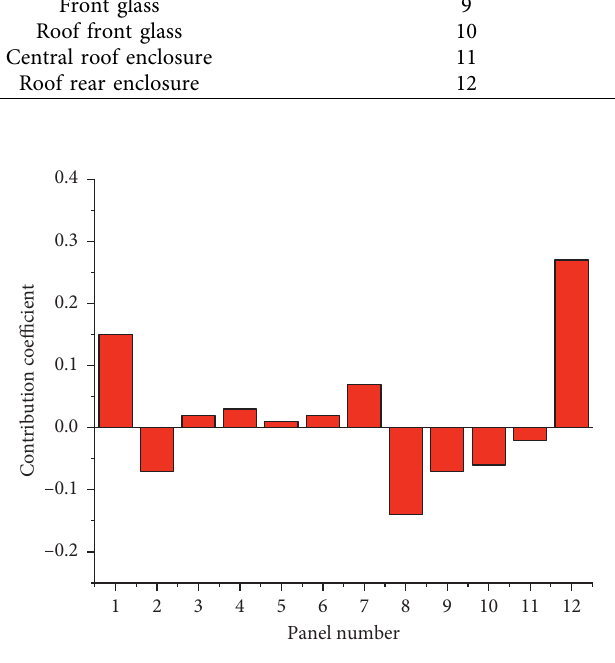
Figure 10: The panel acoustic contribution at 50